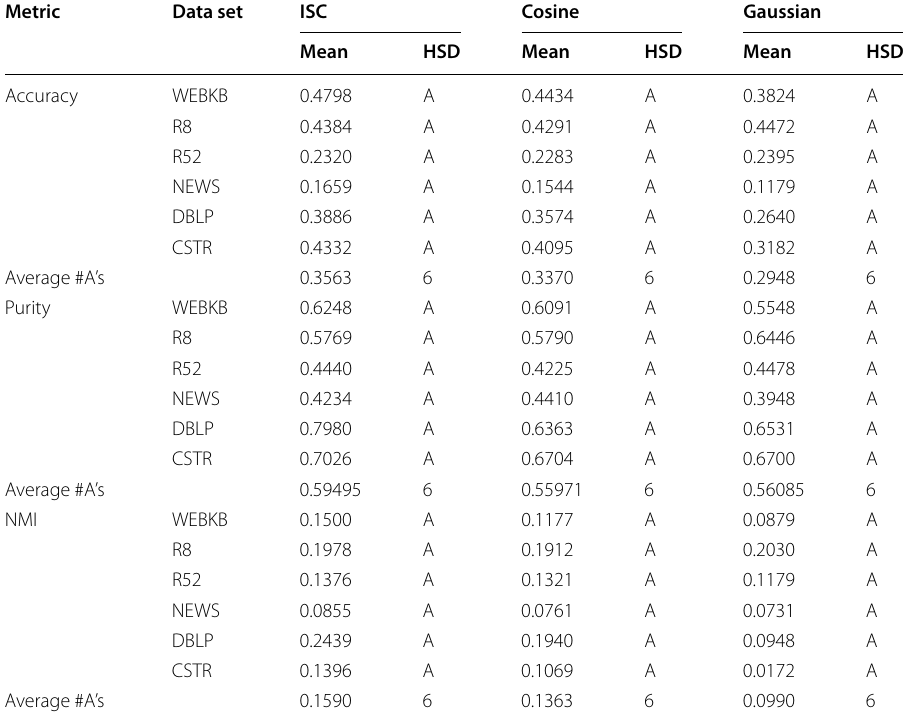
Table 12 Performance of the similarity measures in data sets averaged across all cluster- ing learners